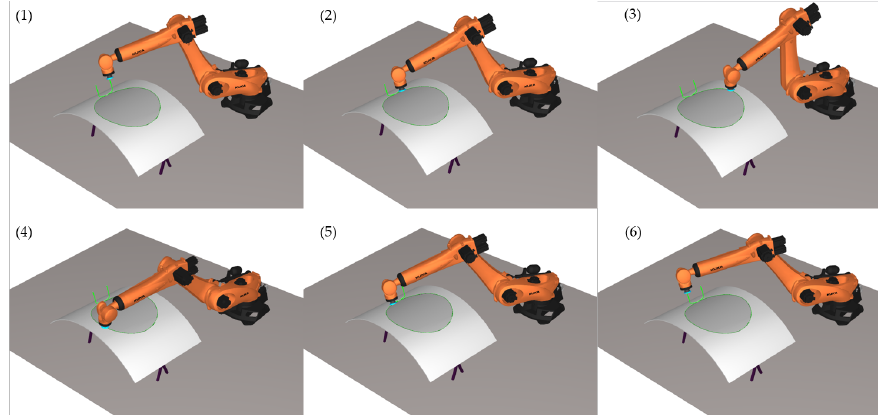
Figure 17. The grinding track of the weld reinforcement.